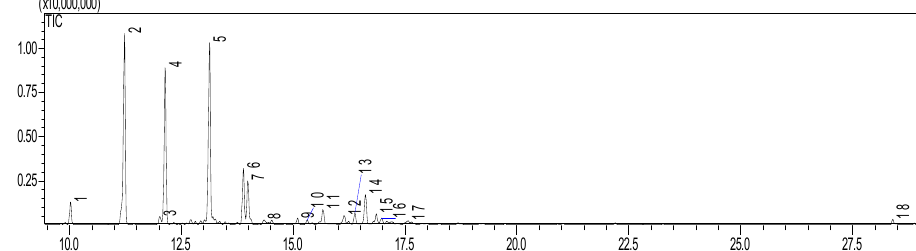
Figure 1. Gas chromatogram of essential oil from Eugenia dysenterica leaves. Peak: 1 ( α -copaene); 2 (E-caryophyllene); 3 (spirolepechinene); 4 ( α -humulene); 5 ( δ -selinene); 6 (selinene <7-epi- α ->); 7 ( δ -cadinene); 8 , 9 and 10 (unidentified); 11 (caryophyllene oxide); 12 (humulol); 13 (humulene epoxide II); 14 (7(11)-Selinen-4 α -ol); 15 (eudesma-4(15),7-dien-1 β -ol); 16 and 17 (unidentified); and 18 (Phytol).